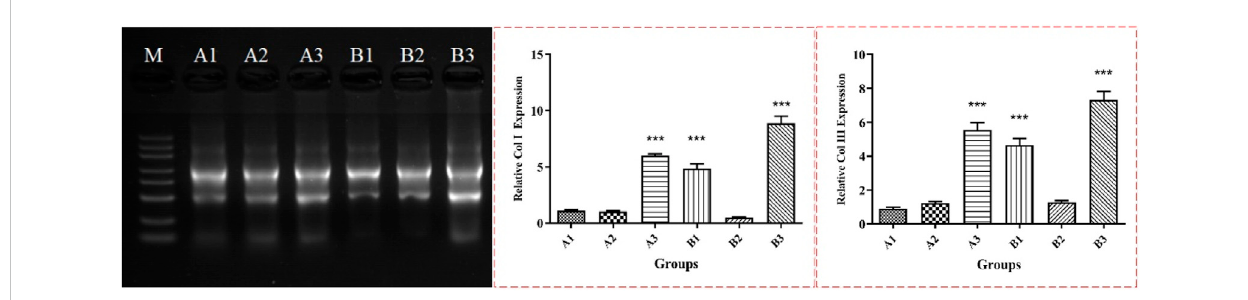
FIGURE 10 RNA electrophoresis results and relative expression levels of Col I and Col III. Note: *** represents signi fi cant difference in numerical comparison between the two groups at the same time point ( p < 0.05). A1, A2 and A3 were corresponding to wound tissue samples of fi sh collagen group on day 1, 3 and 7. B1, B2 and B3 correspond to wound location tissue samples of the self-healing group on day 1, 3 and 7.